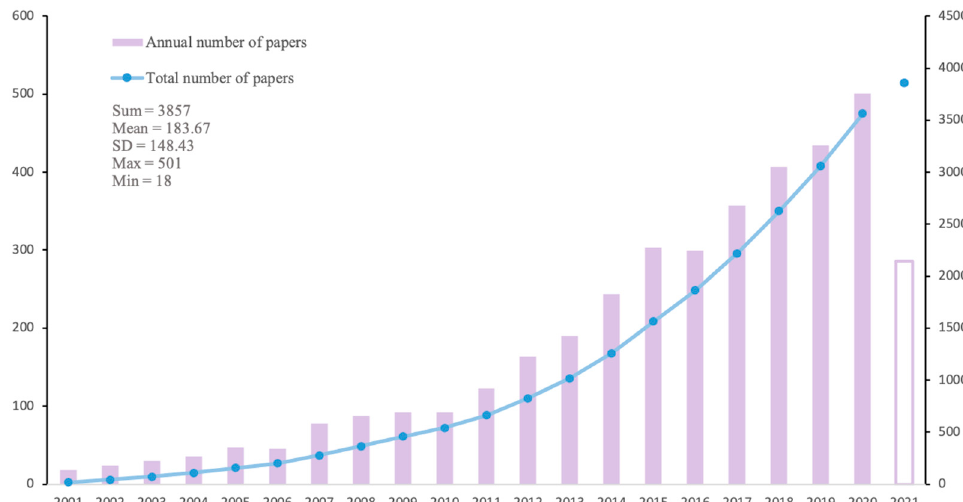
Figure 3. Trends of global research publications.